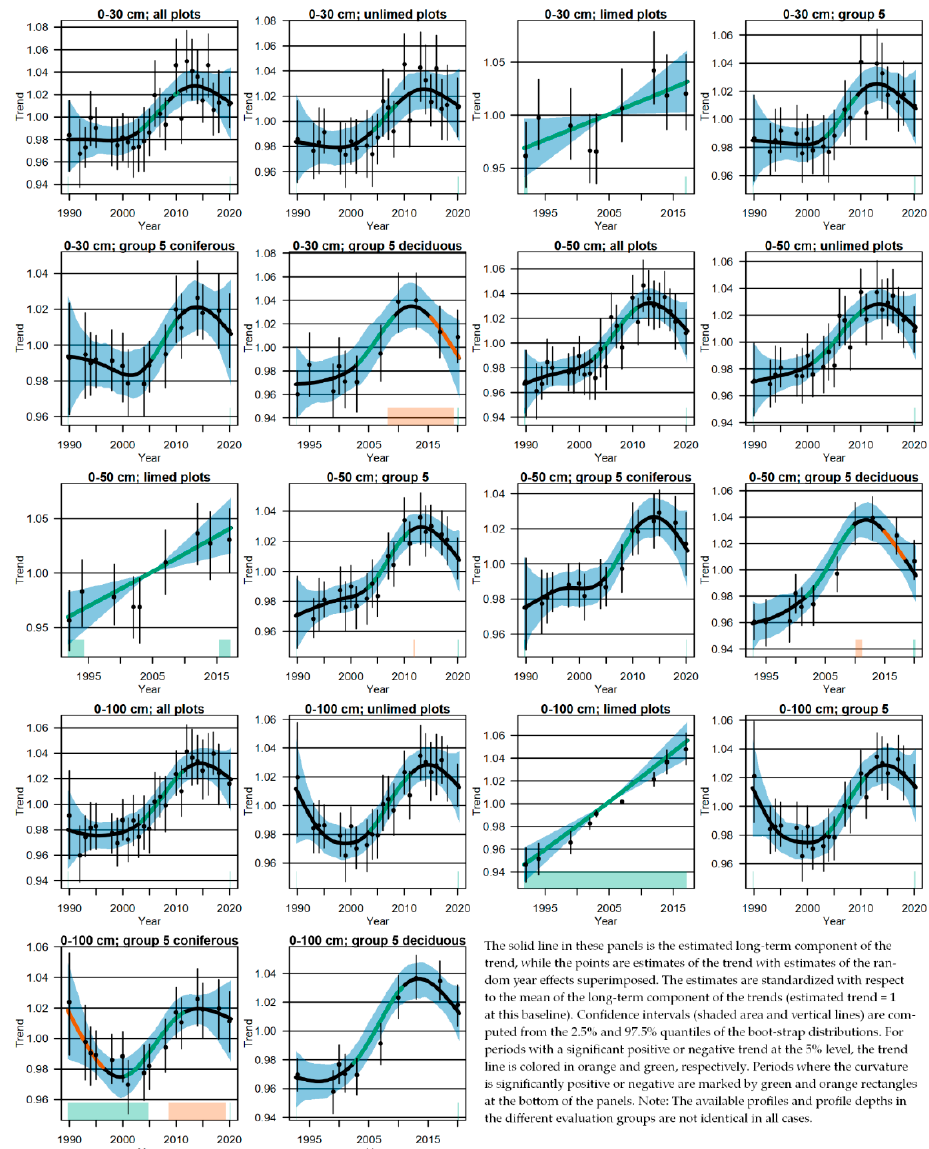
Figure 10. Estimated trends for pH(H 2 O) values in mineral soil for different aggregation depths (0–30 cm, 0–50 cm, and 0–100 cm).